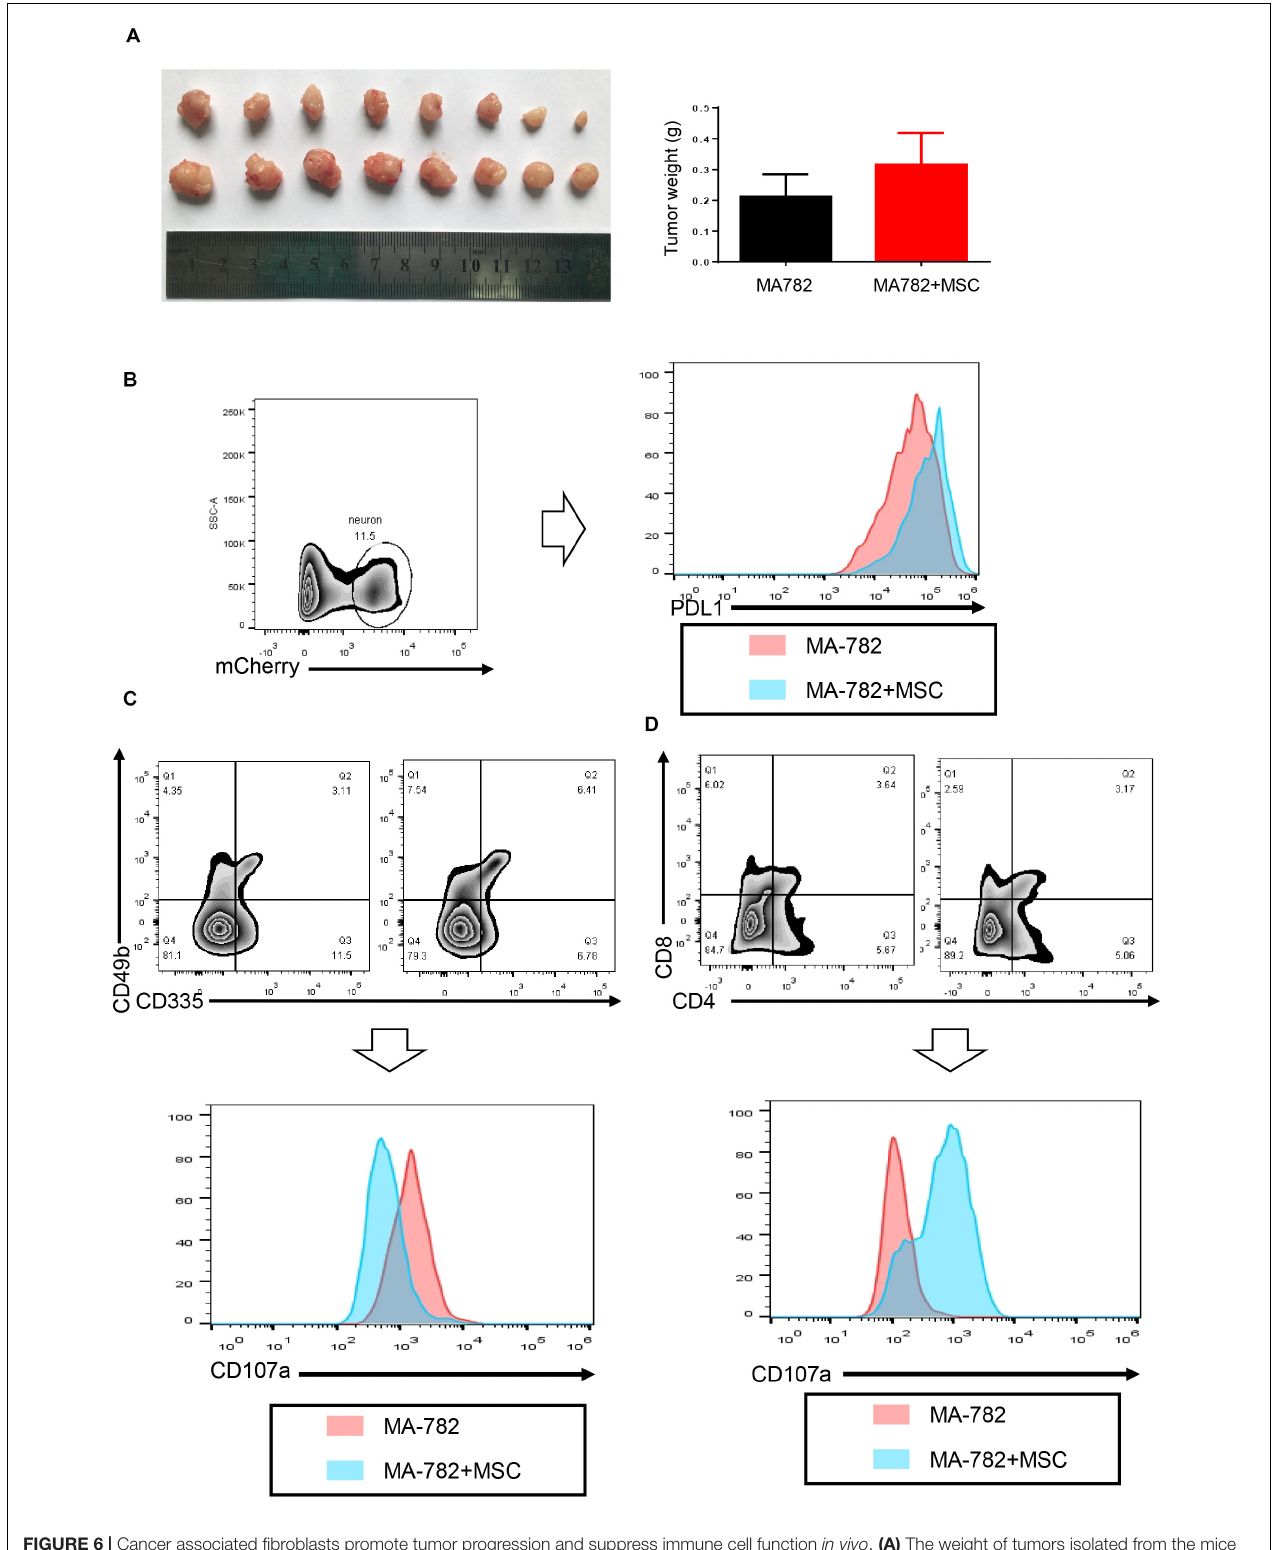
FIGURE 6 | Cancer associated fibroblasts promote tumor progression and suppress immune cell function in vivo . (A) The weight of tumors isolated from the mice with MA-782 cells co-injected with or without MSC ( n = 8). (B) PD-L1 expression of MA-782 which gated as mCherry+. (C,D) CD107a expression of cytotoxicity T cells and NK cells. Error bars represent mean ± SD; **** P < 0.0001; n.s., not significant; by paired two-sided Student’s t -test.